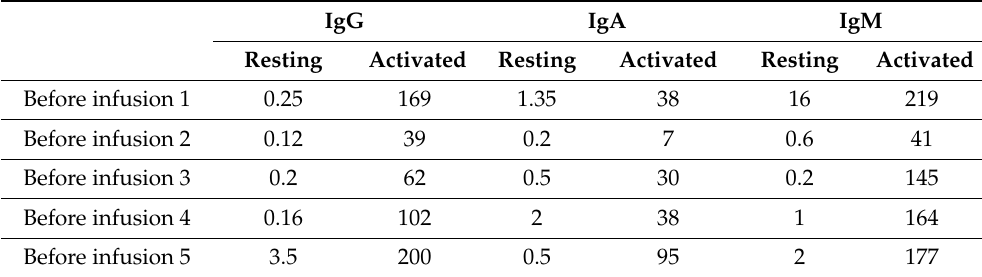
Table 5. B cell response evaluated by in vitro Ig production. Results are expressed as ug/mL/10 6 B